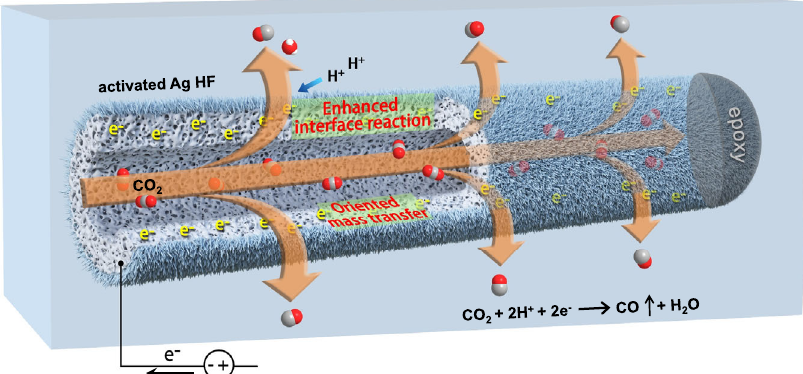
Fig. 1 Function outline of hollow- fi ber silver electrode. Schematic illustration of hierarchical micro/nanostructured silver hollow fi ber for boosting CO 2 electroreduction to